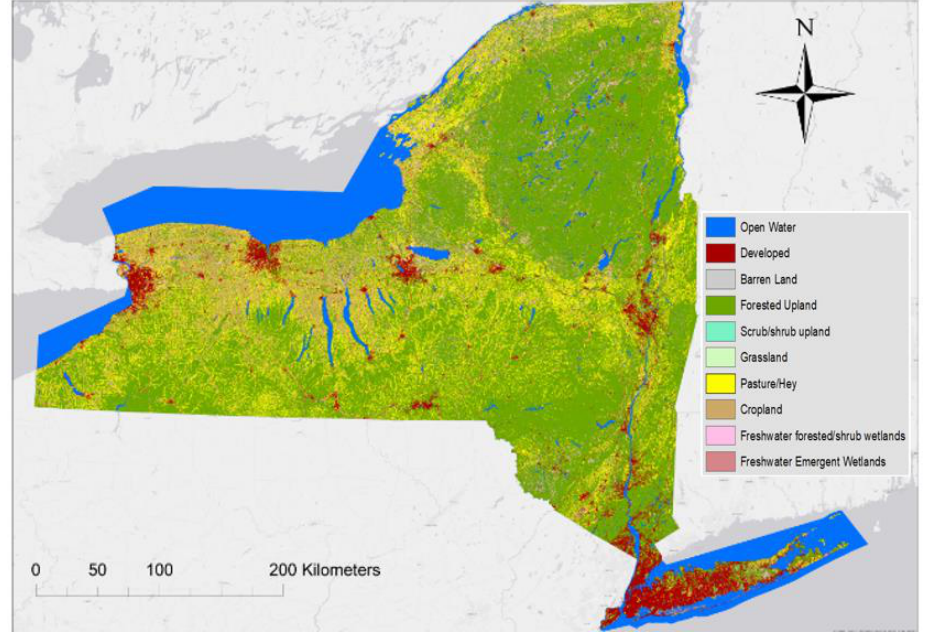
Figure 7 . The generated classified map over